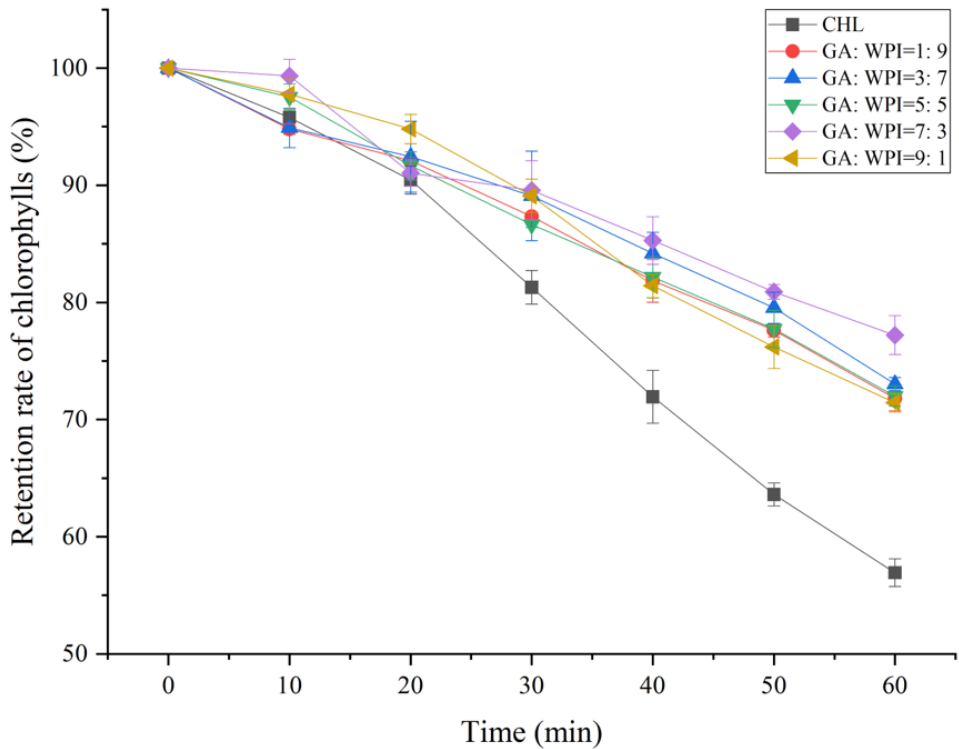
Figure 3. The retention rate of chlorophylls (RT CHs ) of microcapsules covered with different ratios of GA:WPI. ratios of